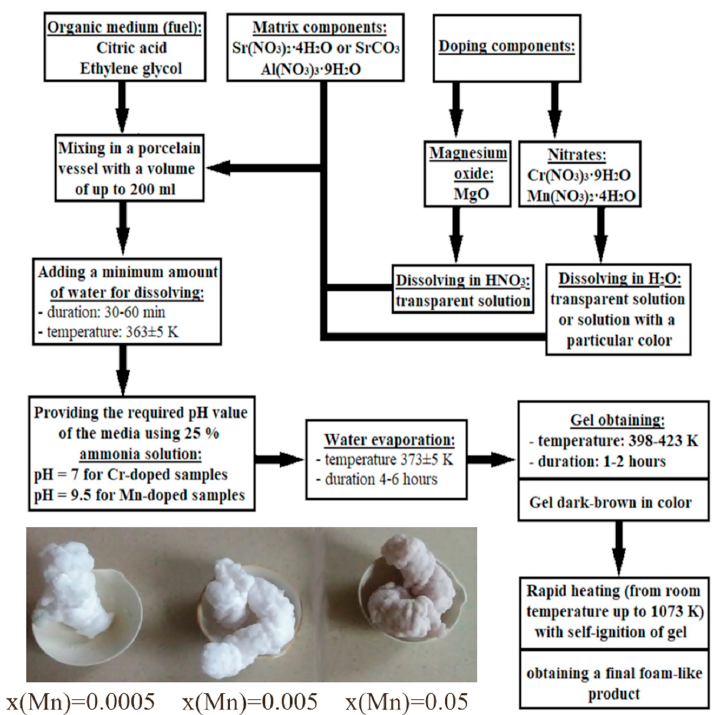
Figure 11. Technological scheme of sol–gel combustion synthesis of Cr 3+ and Mn 4+ doped SrAl 4 O 7 . Inset shows self-combustion products of precursors for SrAl 4 O 7 :xMn materials with x = 0.0005, 0.005, and